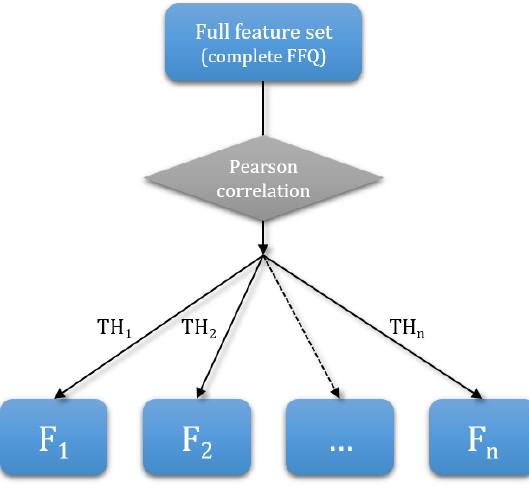
Figure 1. Pearson correlation